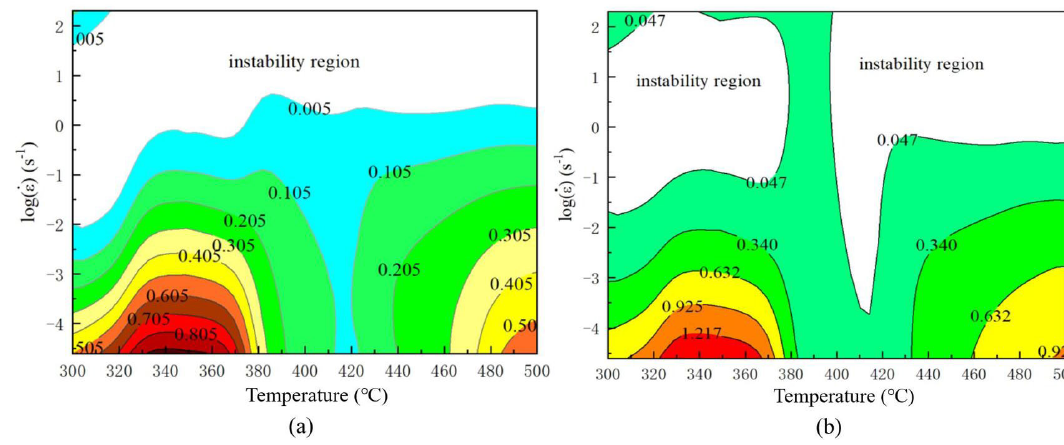
Figure 12. The instability maps at the strain of (a) 0.5 and (b) 0.9.